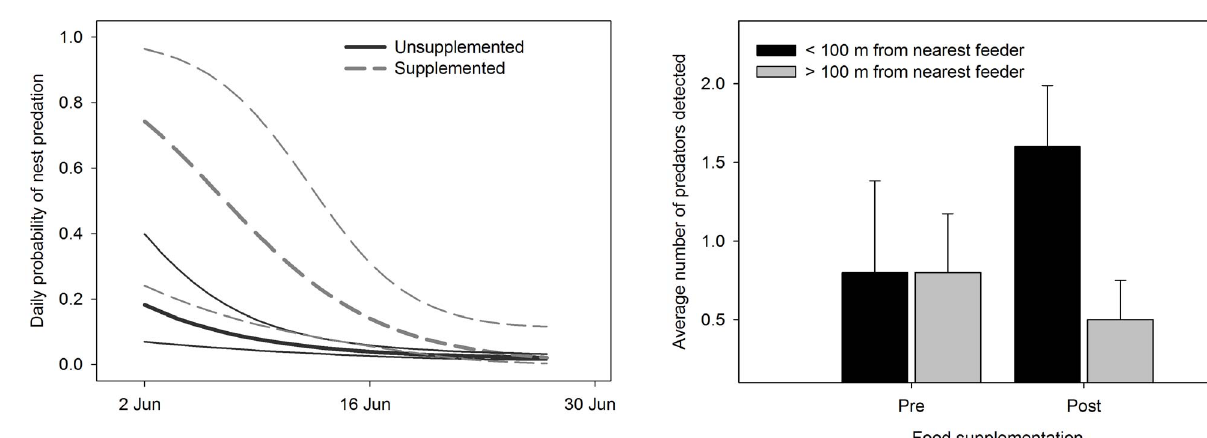
Figure 4. Daily probability of nest predation at supplemented and unsupplemented nest sites. Estimates of daily probability of nest predation for Dusky Flycatchers (heavy lines) with 95% upper and lower confidence limits (fine lines) generated from the best-supported model from our supplemental food experiment (Nest predation = Food + Date + Date 2 + Food*Date 2 ; Table 4). Daily nest predation was higher in areas near feeders (dashed line) compared to areas further from feeders (solid line), but the effect dissipated later in the season.